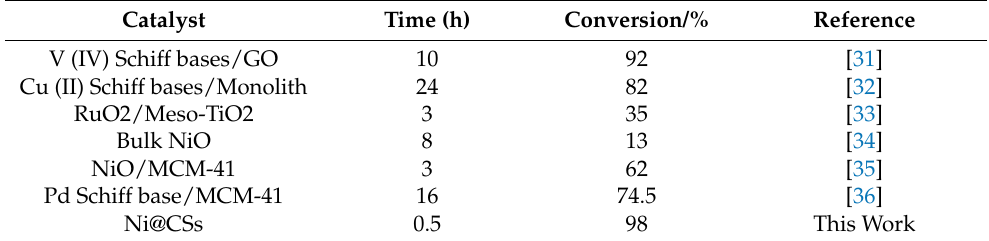
Table 3. Catalytic activity of various heterogeneous catalysts in cyclohexene epoxidation. Catalyst Time